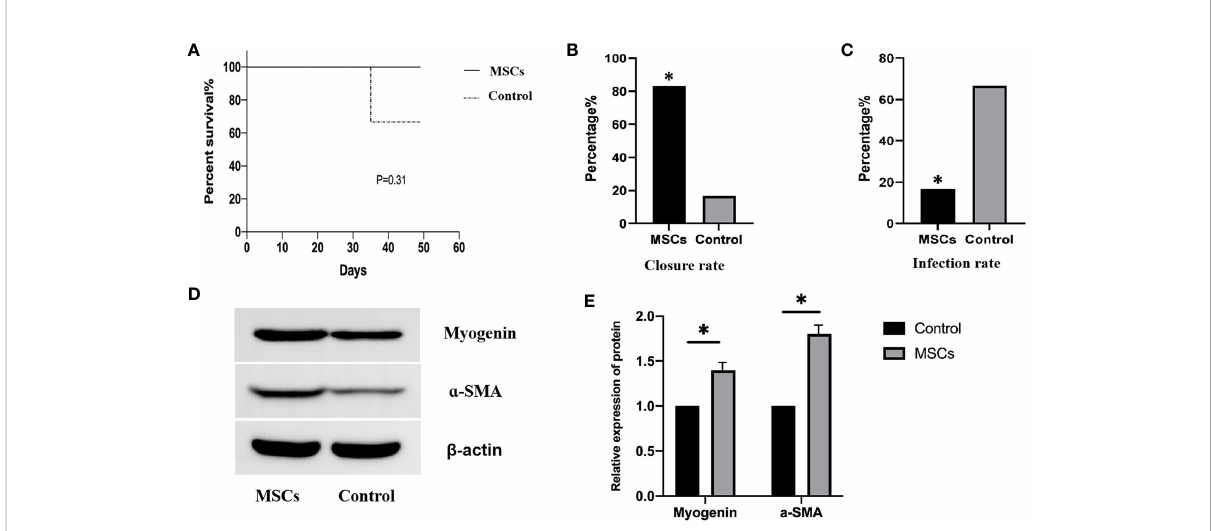
FIGURE 6 Clinical outcomes for the animals in the two groups. (A) , Log-rank test showing mortality rate (P= 0.31) log-rank test. (B) , Fisher exact t-test showing the complete closures of EALs in the MSCs group (83.3%) and control group (16.7%). P<0.05. (C) , Fisher exact t-test showing the infection proportions of EALs in MSCs group (16.7% (1/6)) and in control groups (66.7%(4/6)) P < 0.05. (D) , Western blotting showing myogenin and a-SMA protein expression after MSCs engraftment. (E) , Quantitative analysis of the protein expression levels of myogenin and a-SMA.